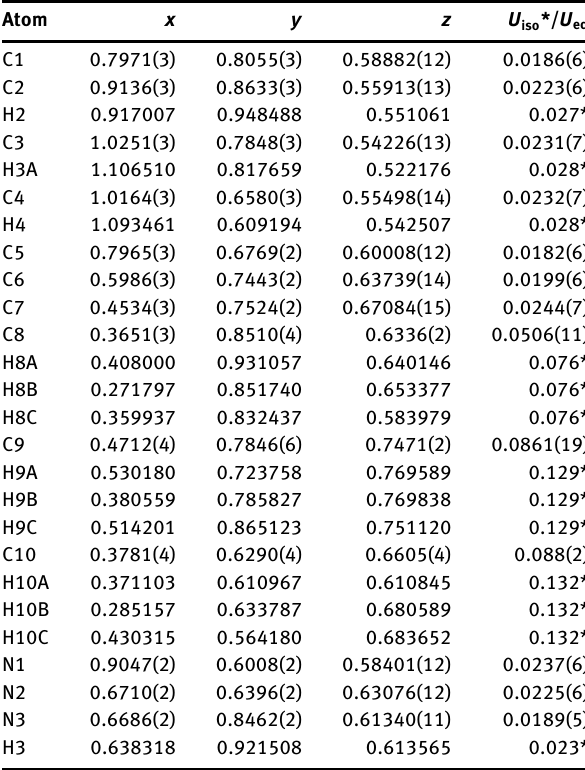
Table 2: Fractional atomic coordinates and isotropic or equivalent isotropic displacement parameters (Å 2